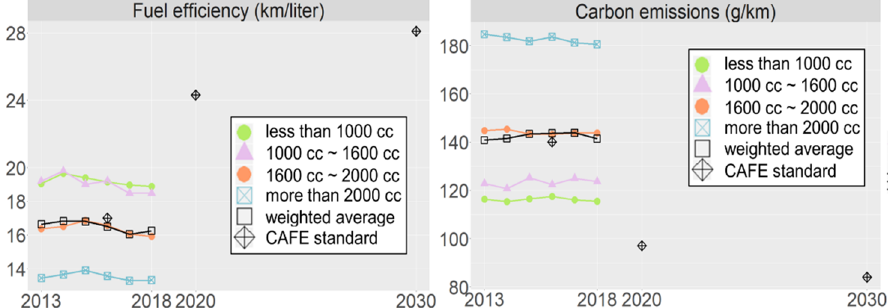
Figure 4. Observed versus Corporate Average Fuel Economy (CAFE) standards in terms of fuel efficiency and carbon emissions in the passenger car sector (source: Korea Energy Agency [17]).